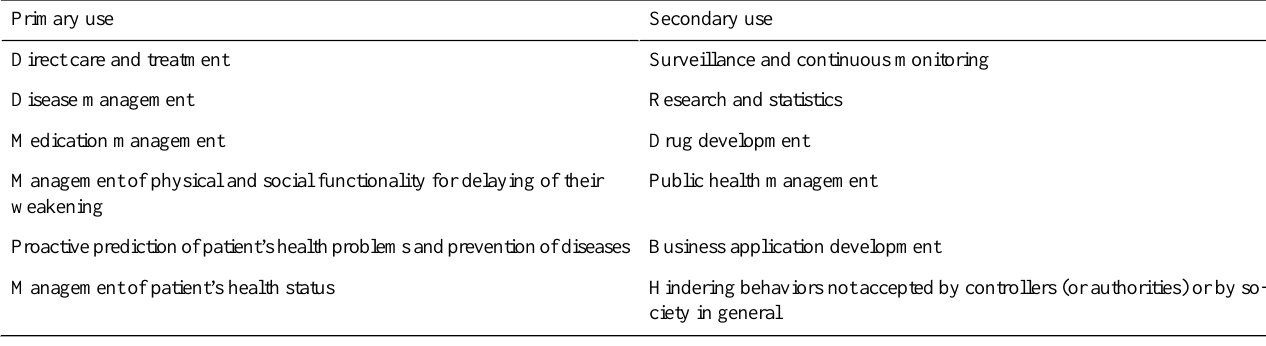
Table 1. Typical primary and secondary uses of health